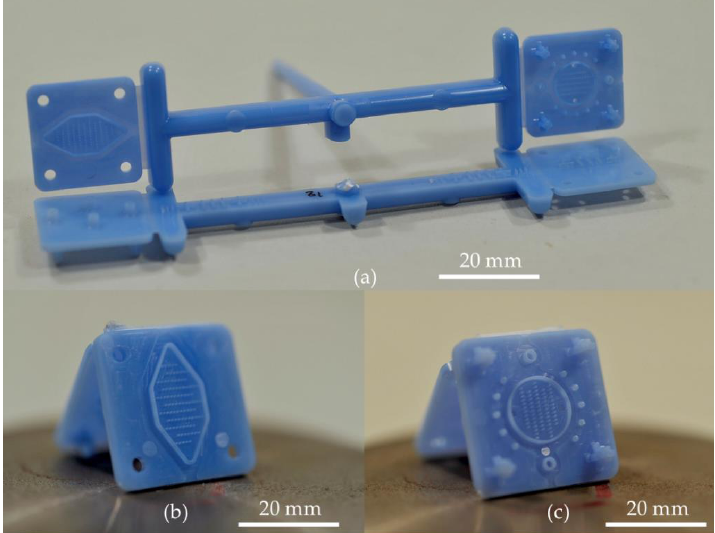
Figure 3. Molded geometry with fingerprint structures on the part and runners ( a , b ), and measurement positions on Cavity 1 ( c ) and Cavity 2 ( d ).